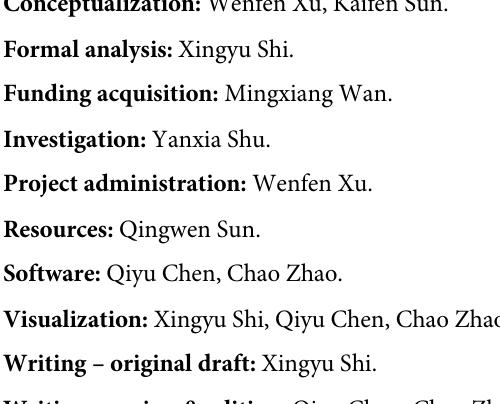
S2 Table. The intron containing genes of the cp genomes of three Carpesium species and their exon and intron lengths. S3 Table. Codon usage in chloroplast genomes of three Carpesium species. S4 Table. SSR type and number identified in three Carpesium species. S5 Table. Repeat sequences ( � 30bp) identified in three Carpesium